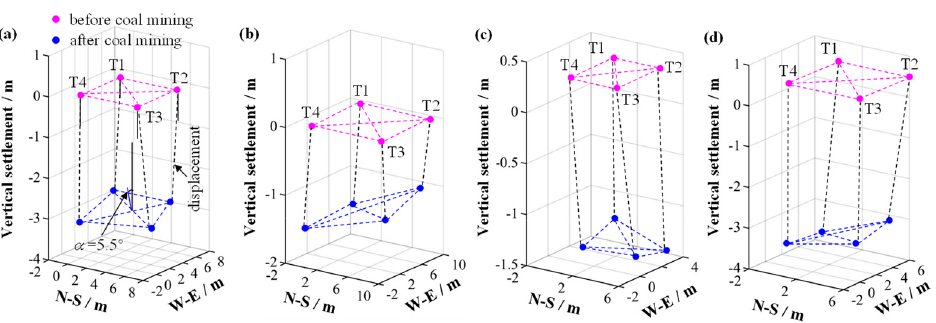
Figure 13. The spatial positions of four bases of: ( a ) Pylon 37#, ( b ) Pylon 36#, ( c ) Pylon 53# and ( d ) Pylon 103# before coal mining and after 20 months of coal mining.